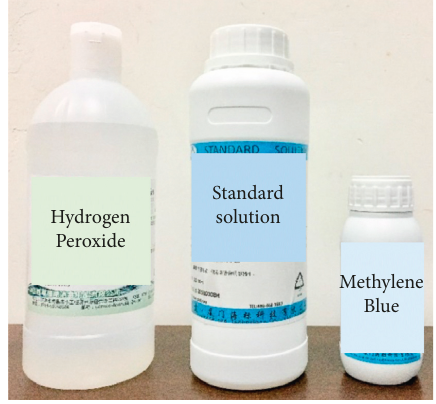
Figure 2: The reagent used for the methylene blue titration